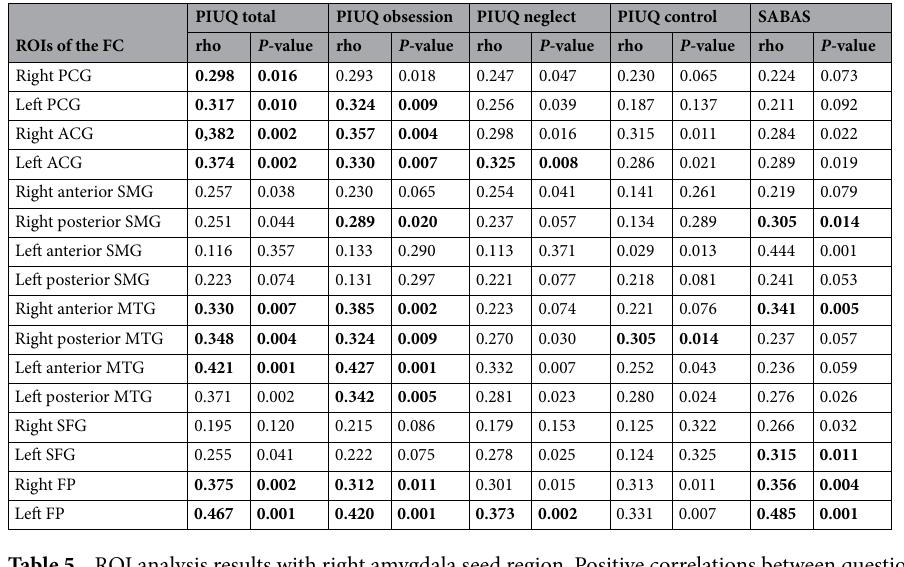
Table 5. ROI analysis results with right amygdala seed region. Positive correlations between questionnaire scores and FCs. Rho- Spearman’s correlation coefficients and uncorrected P -values are presented; PIUQ Problematic Internet Use Questionnaire; SABAS Smartphone Application-Based Addiction Scale; PCG posterior cingulate gyrus. ACG anterior cingulate gyrus; SMG supramarginal gyrus, MTG middle temporal gyrus; SFG superior frontal gyrus; FP frontal pole; Significant correlations after Benjamini–Hochberg correction (q = 0.05) are written in